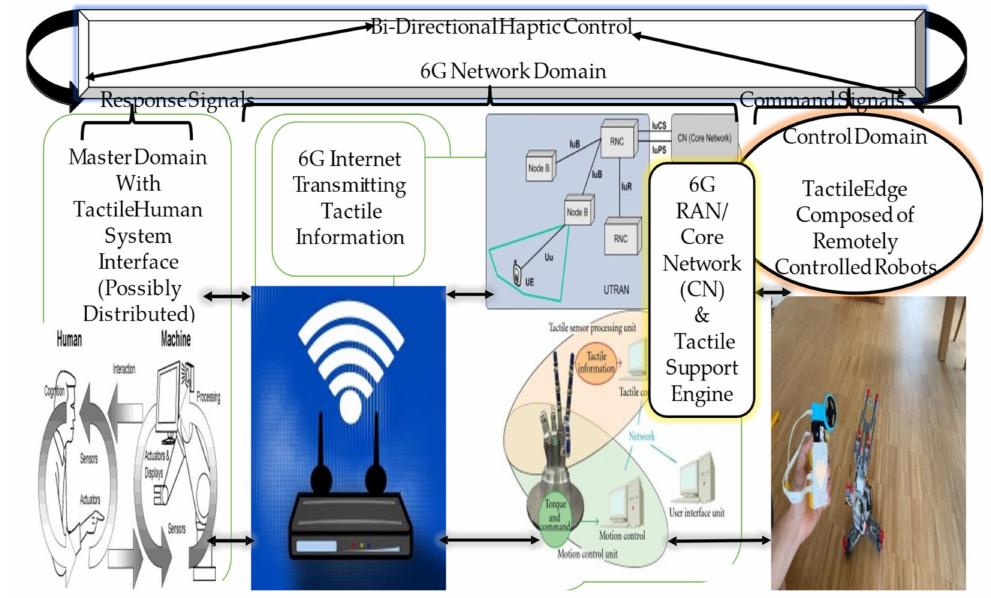
Figure 10. Functional representation of the 6G enabled Tactile Internet